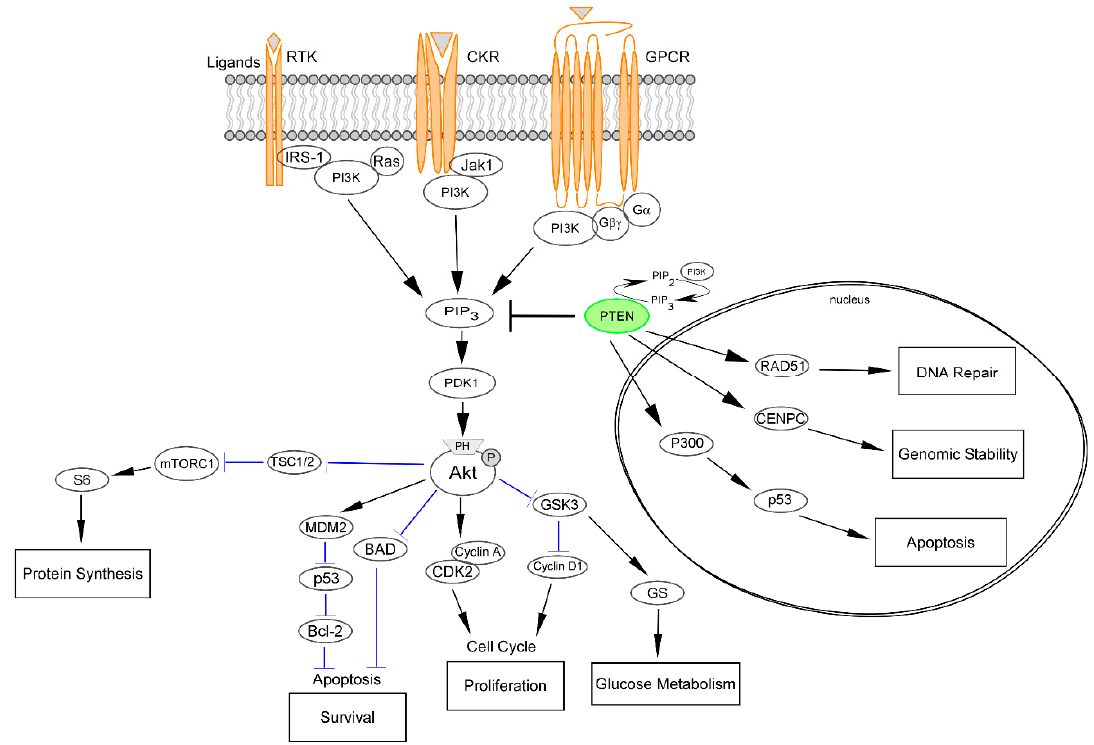
Figure 2. PI3K/Akt/mTOR signaling and its interaction with PTEN. The PI3K pathway regulates diverse cellular processes, including protein synthesis, cell survival, proliferation, glucose metabolism, apoptosis, DNA repair, and genome stability. Akt-mediated phosphorylation inhibits the activity of the TSC1-TSC2 complex, also known as hamartin-tuberin. This is a critical step for the negative regulation of mTORC1, whose activity controls anabolic processes. Another important downregulation of Akt phosphorylation is towards BAD, while MDM2 activity is enhanced, promoting the degradation of the tumor-suppressor p53, which also plays a part in the P300-mediated cell apoptosis. Cell cycle regulation occurs by means of cyclins A and D stimulation and GSK3 inhibition. The latter event is also responsible for increased glucose metabolism. PTEN is intimately involved in the regulation of these mechanisms through its substrate PIP3. Of note, the activity of PTEN in the cell nucleus that leads to cell survival control is related to the upregulation of key mediators, such as RAD51, CDNPC, and P300. RTK, receptor tyrosine kinase; CKR,